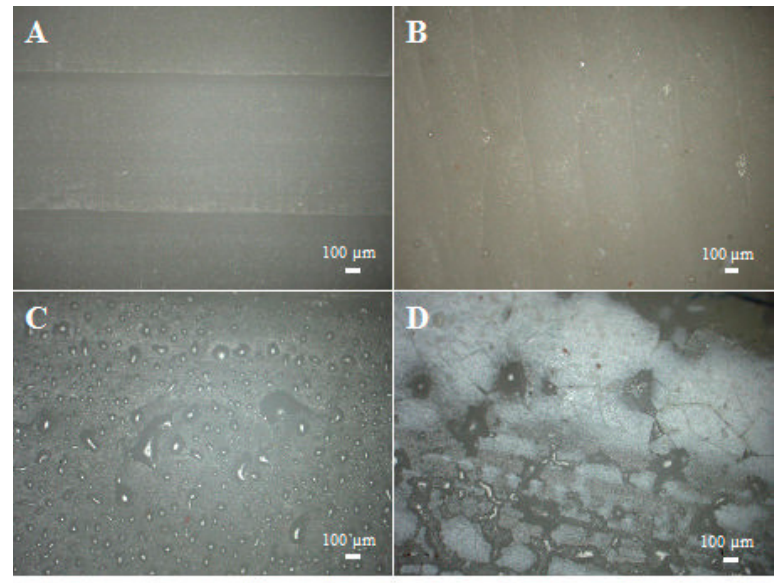
Figure 8. Photos of a side of the samples, ( A )—glass, degassed; ( B )—glass, non-degassed; ( C )—silicone, non-degassed; ( D )—silicone, degassed.